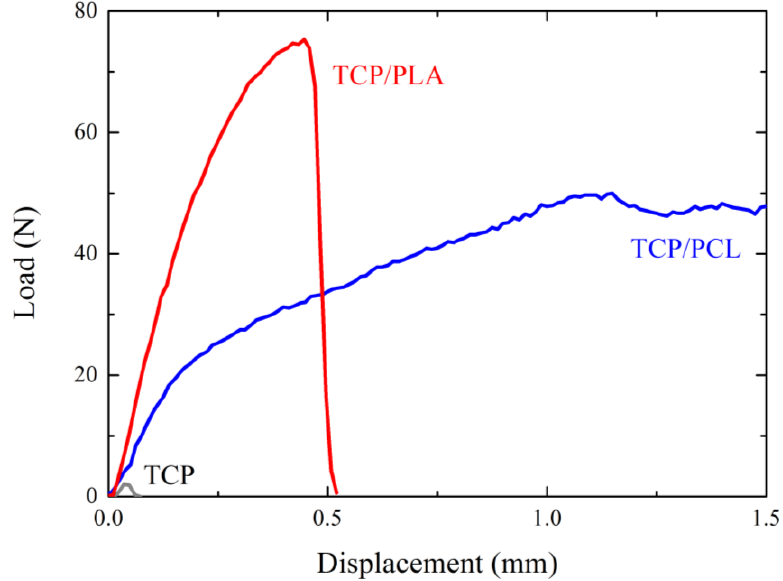
Figure 4. Representative load-displacement curves obtained from 4-point bending tests performed on bare TCP, and on TCP/PCL and TCP/PLA hybrid samples.